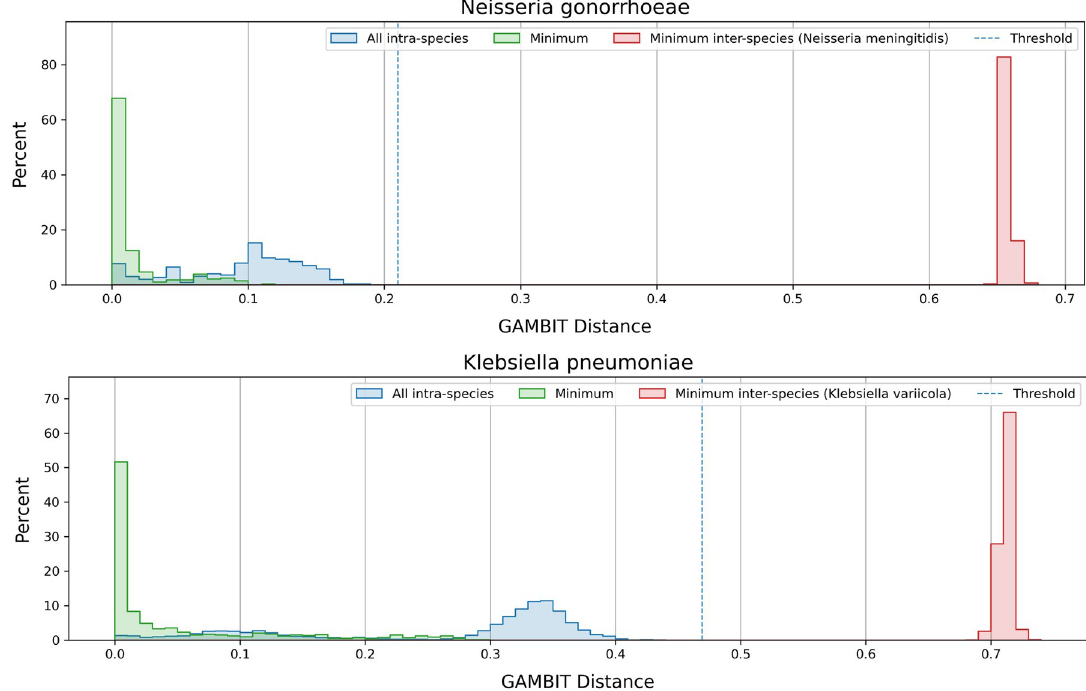
Fig 4. Distribution of GAMBIT distances within a species and to the nearest sister taxon in the GAMBIT reference database. Three histograms are shown in each panel (each normalized independently). The green histogram represents the distribution of GAMBIT distances from each reference genome in the species to the closest genome also within the same species. The blue histogram represents the distribution of GAMBIT distances for all pairwise comparisons within the species. The red histogram represents the distribution of GAMBIT distances from each genome in the species of interest to the closest genome in the species’ closest sister taxon. The dashed blue line represents the classification threshold for that species in the GAMBIT database, which in both cases was derived from the maximum intra-species distance. Panel A shows Klebsiella pneumoniae and its closest sister taxon Klebsiella variicola, panel B shows Neisseria gonorrhoeae and its closest sister taxon Neisseria meningitidis).